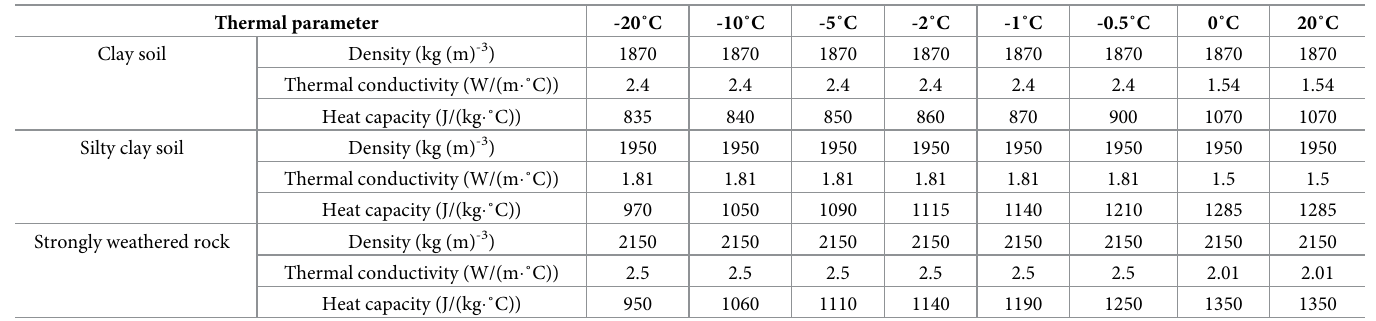
Table 2. Thermal parameters of layers of strongly weathered rock, silty clay soil, and clay soil.